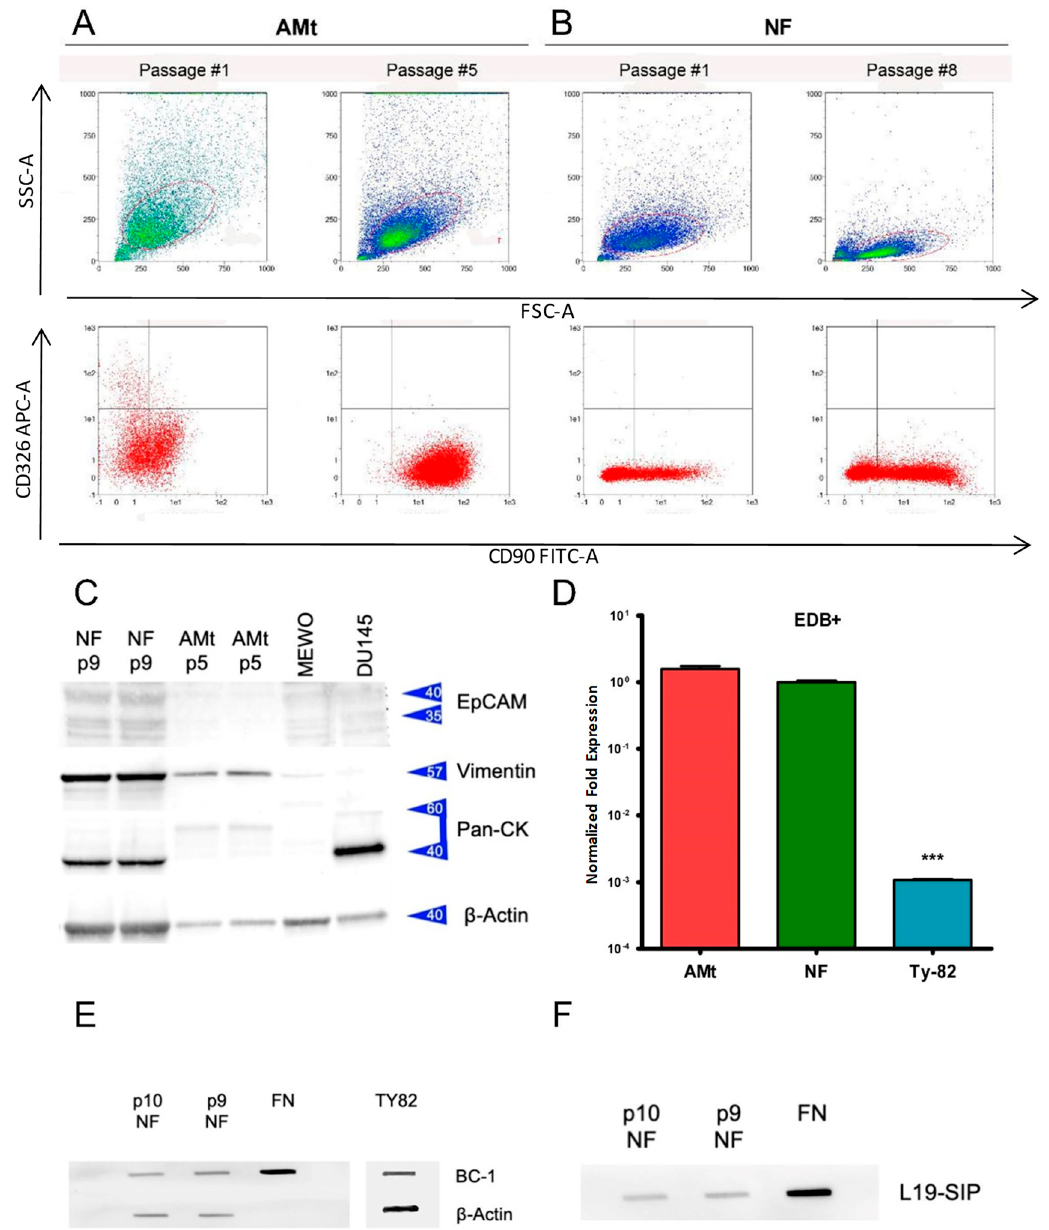
Figure 4. Immunophenotyping of primary cell culture in AMt ( A ) and NF ( B ) at the first and following passages. Flow cytometry shows the expression of thymocyte-mesenchymal (CD90 + ) and epithelial (CD326 + ) markers. CD326 + cells disappear at passage 5 in Amt, whereas they are absent in NF. ( C ) Western blot evaluating the expression of EpCAM, Vimentin, Pan cytokeratins (Pan-CK), and Beta acting as loading control in NF and AMt at passage 9 and 5, respectively. MEWO and DU145 cell lines were included as control. ( D ) Fold change expression of ED-B fibronectin in AMt and NF primary culture and in TY82 thymic carcinoma cell line (*** p < 0.001). The difference in expression was significative between primary cultures and TY82. Slot-blot assay of ED-B expression in NF cells at passage 9 and 10 was revealed by BC-1 monoclonal antibody ( E ) and L19-SIP ( F ). Using Western blot, we evaluated the expression of EpCAM, vimentin, and pan-cy- 4C, Supplementary Figure S3). We included lysates of the melanoma MEWO and prostatic cancer DU145 cell lines as positive controls for vimentin and cytokeratin expression. Ep- CAM was not expressed in any of the cells evaluated, whereas vimentin was strongly expressed in NF and AMt cells. Pan-cytokeratin sating suggests the expression of type I